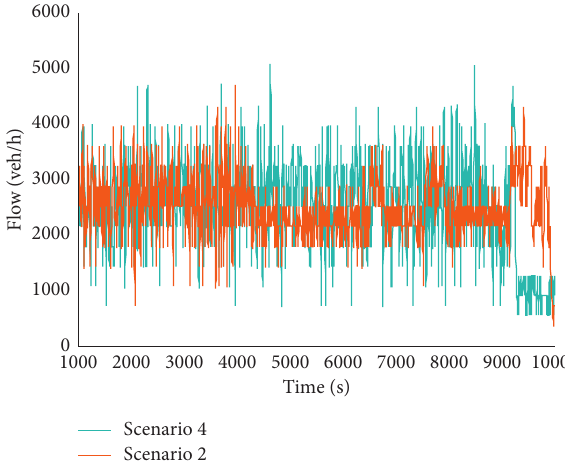
Figure 7: The sixth traffic flow comparison diagram between scenario 2 and scenario